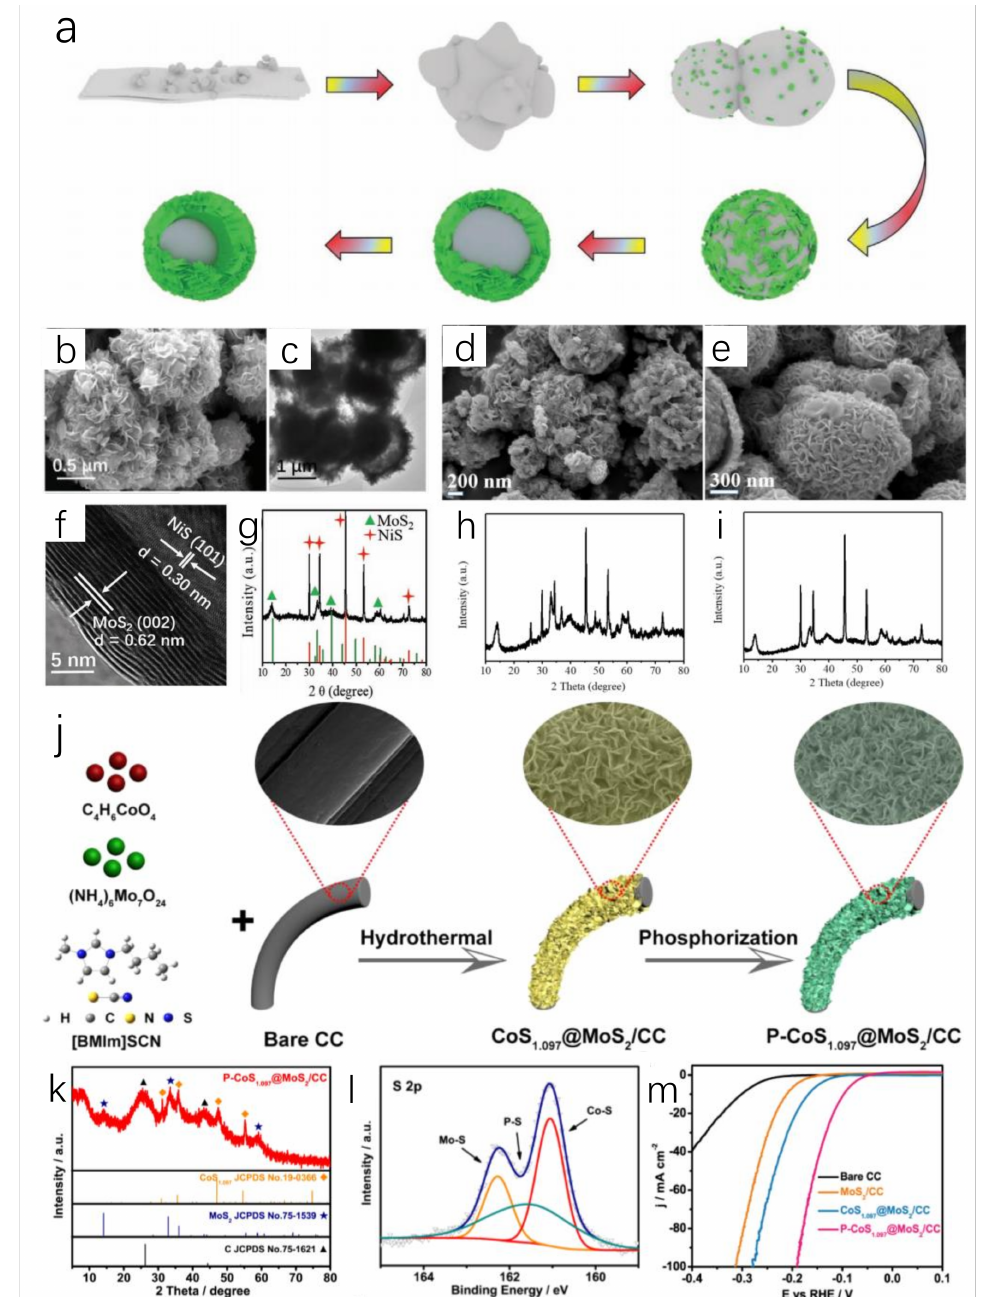
Figure 5. Schematic illustration of the formation mechanism of the yolk–shell nanostructure ( a ), SEM ( b ) and TEM ( c ) images of [BMIM]SCN − derived MoS 2 /NiS, SEM image of the KSCN − derived products ( d ), SEM image of the [BMIM]Cl/KSCN-derived products ( e ), HRTEM image ( f ) and XRD pattern ( (cid:78) (green), (cid:70) (red) represent MoS 2 and NiS, respectively) ( g ) of [BMIM]SCN − derived MoS 2 /NiS, XRD pattern of KSCN − derived products ( h ), XRD pattern of [BMIM]Cl/KSCN − derived products ( i ). Reprinted with permission from ref. [93], copyright 2019 wiley. Schematic illustration of the synthetic procedure of P − CoS 1.097 @MoS 2 nanosheets ( j ), XRD pattern ( ♦ (orange), (cid:70) (purple), (cid:78) (black) represent CoS − CoS 1.097 , MoS 2 , C, respectively) ( k ) and S 2p XRS spectra ( l ) of P 1.097 @MoS 2 nanosheets, LSV curves of P − CoS 1.097 @MoS 2 and control samples for HER ( m ). Reprinted with permission from ref. [95], copyright 2021